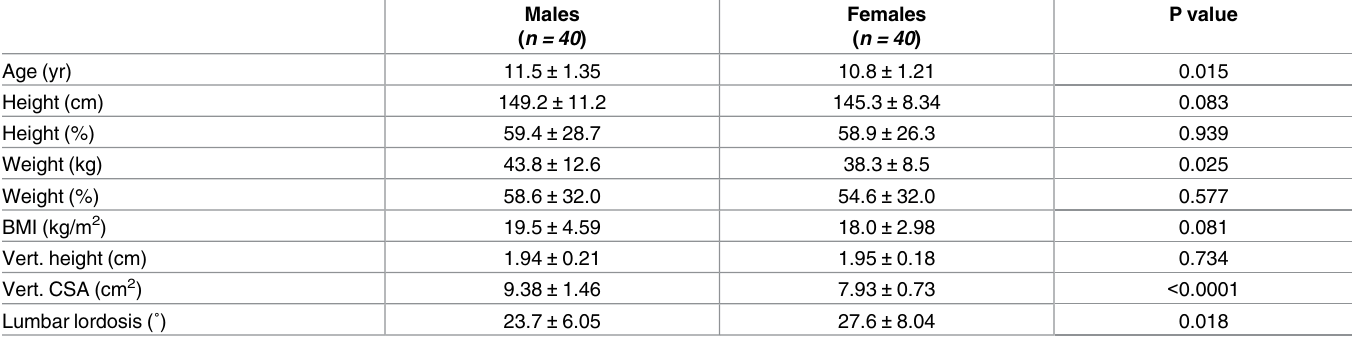
Table 1. Ages, anthropometric characteristics, and MRI measuresof vertebral morphology and degree of lumbar lordosis in 80 healthy adolescent boys and